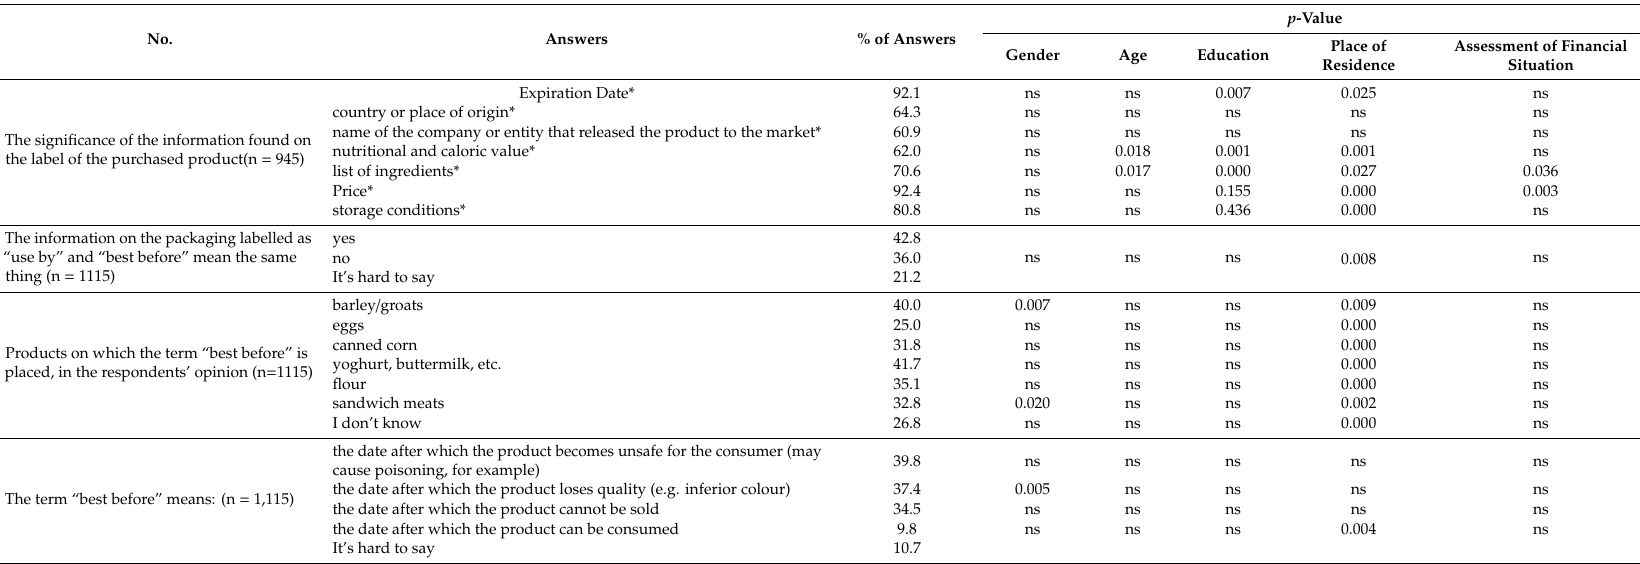
Table 4. Importance of the expiry date of purchased products in the opinion of consumers and knowledge of basic related